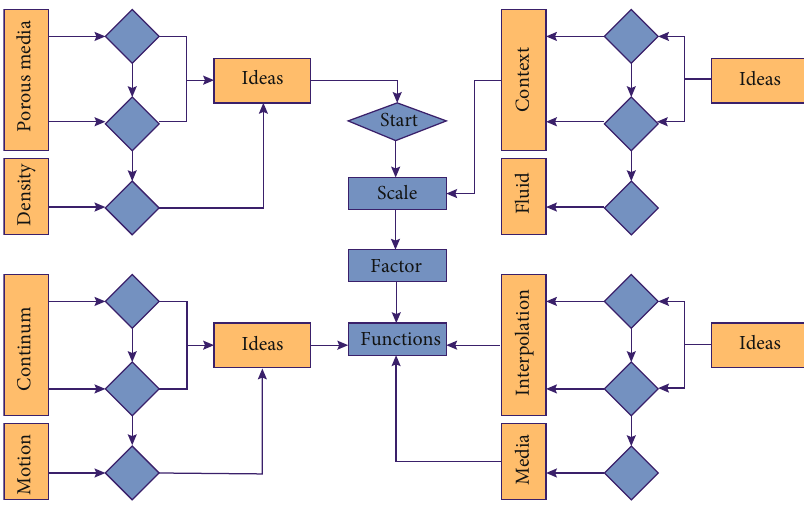
Figure 2: Processing fl ow processing diagram for HSV